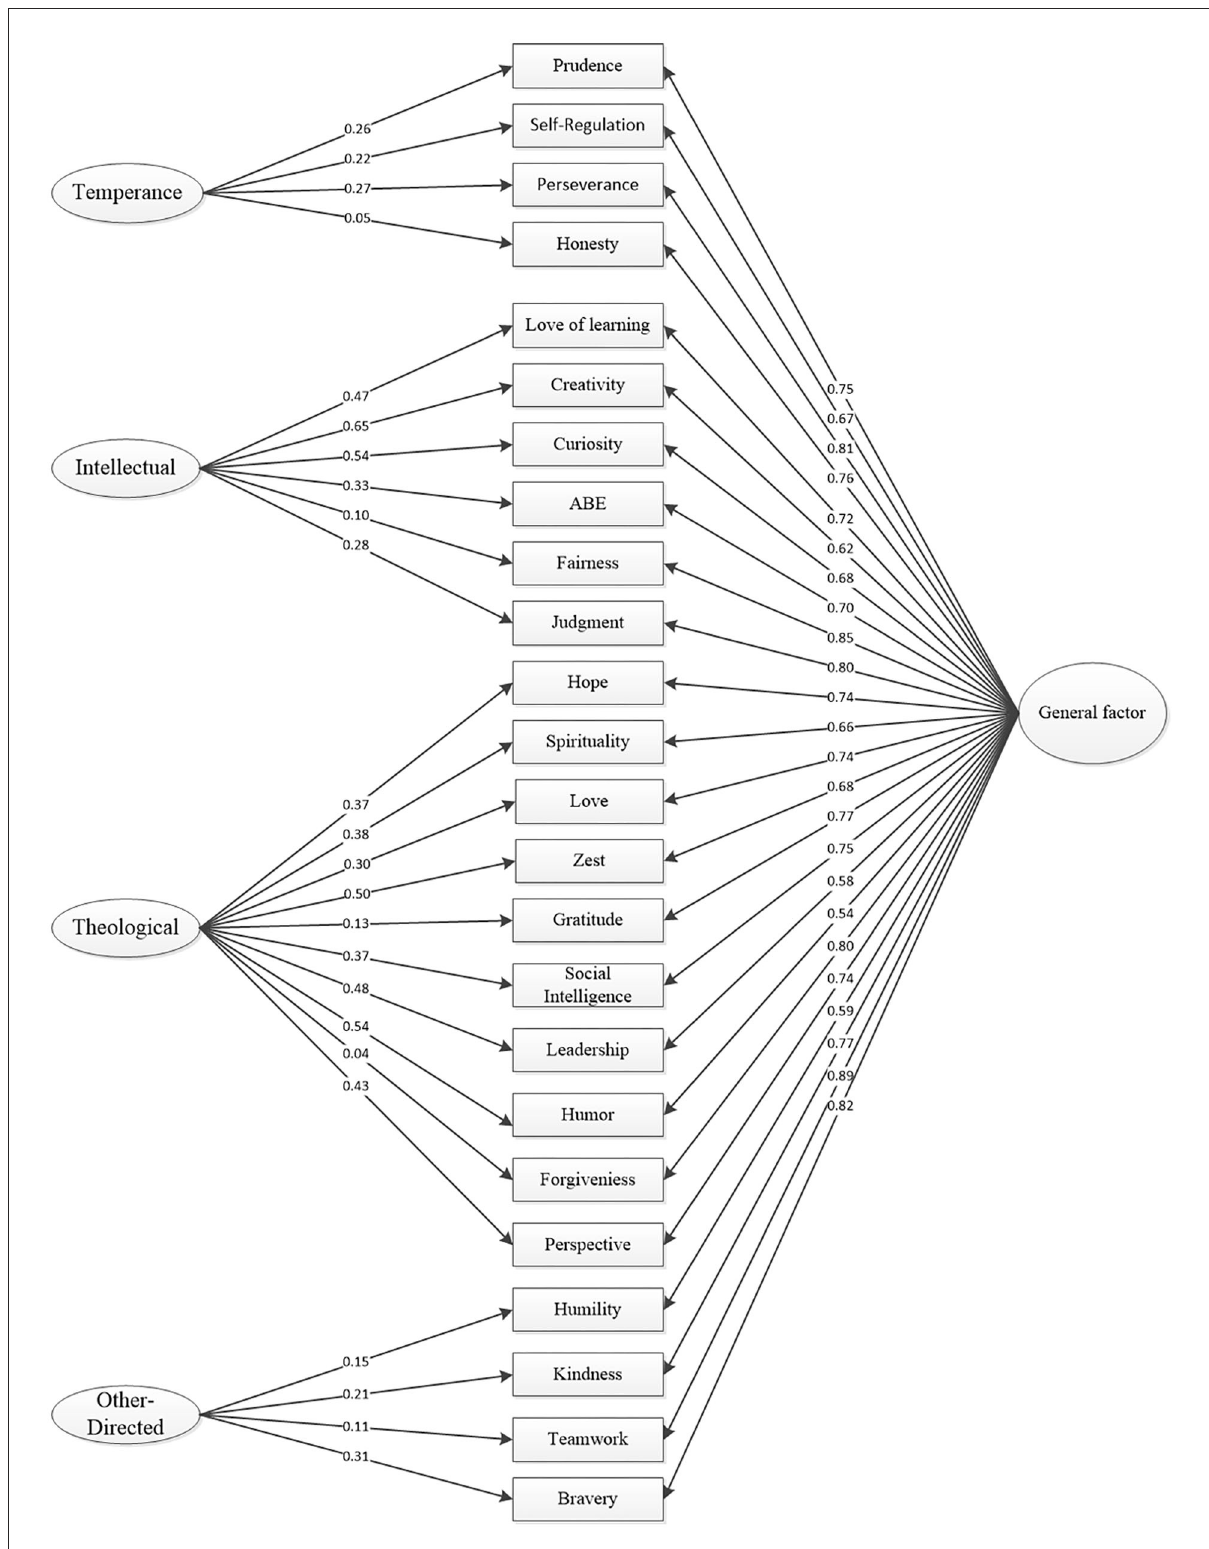
FIGURE1 Bifactor model of the Chinese version VIA